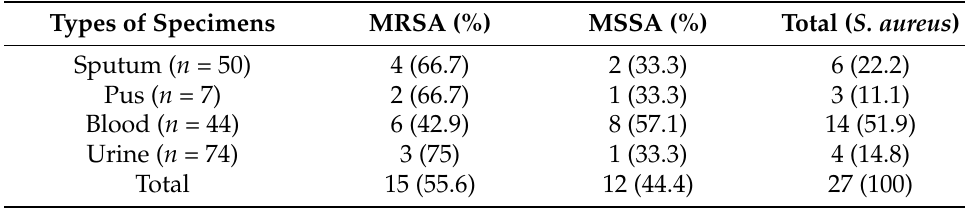
Table 2. Distribution of MRSA and MSSA in different clinical